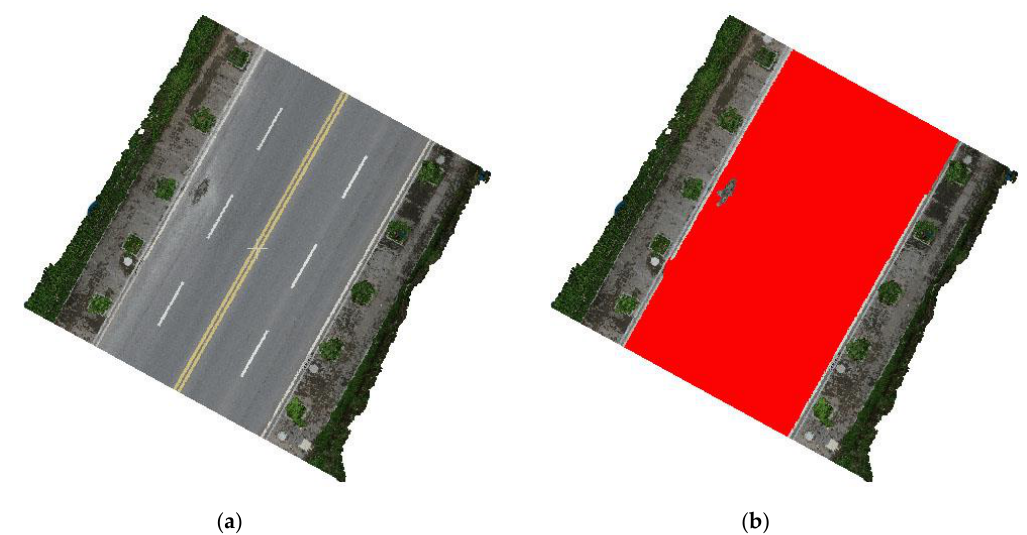
Figure 7. Road surface extraction with ( a ) and without ( b ) fixing the distress region.